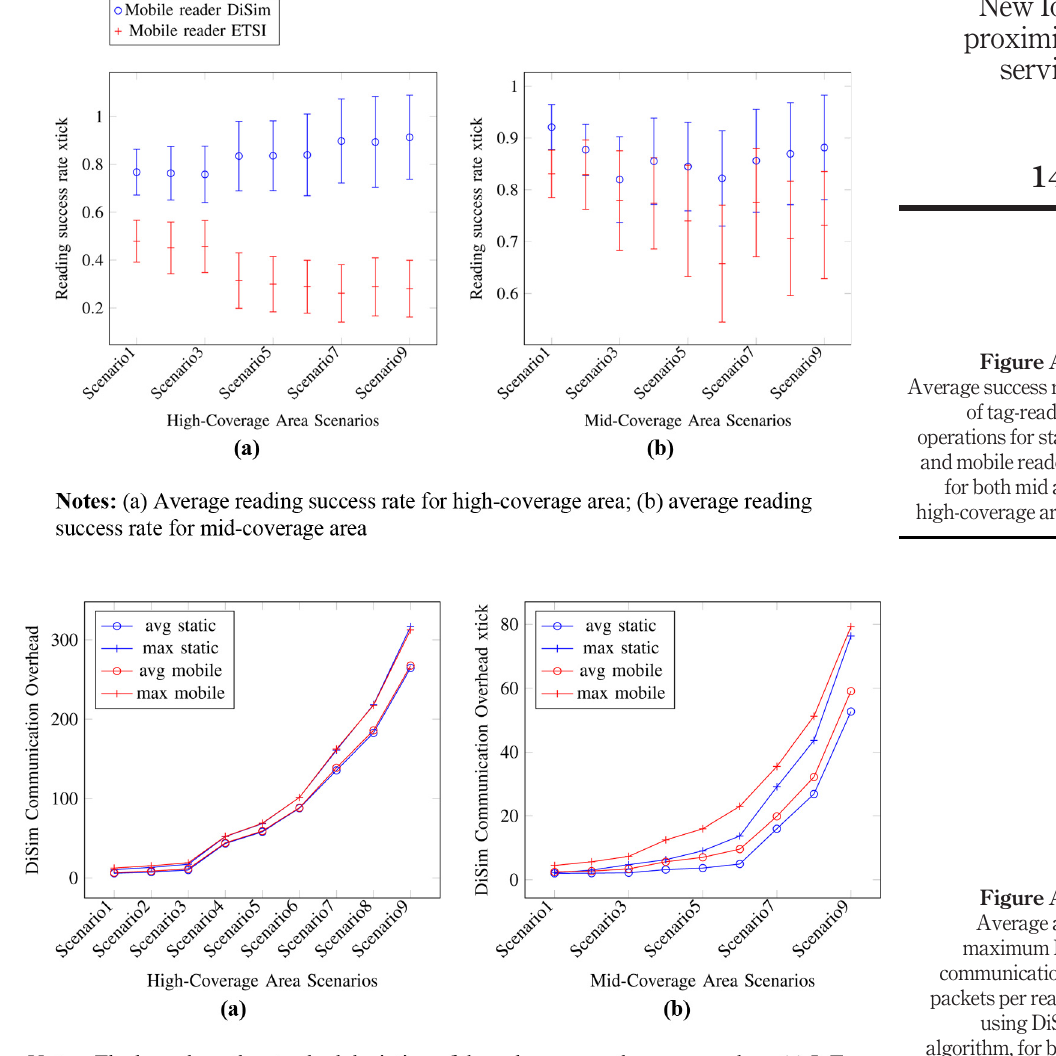
Figure A6. Average and maximum IoT communications/ packets per reader using DiSim algorithm, for both mid and high- coverage